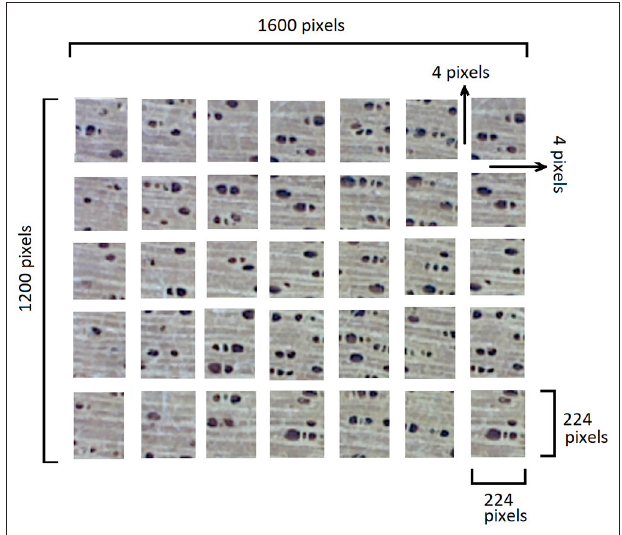
FIGURE 6 | Dividing the original image into sub-images (taken from Figueroa-Mata et al., 2018b).